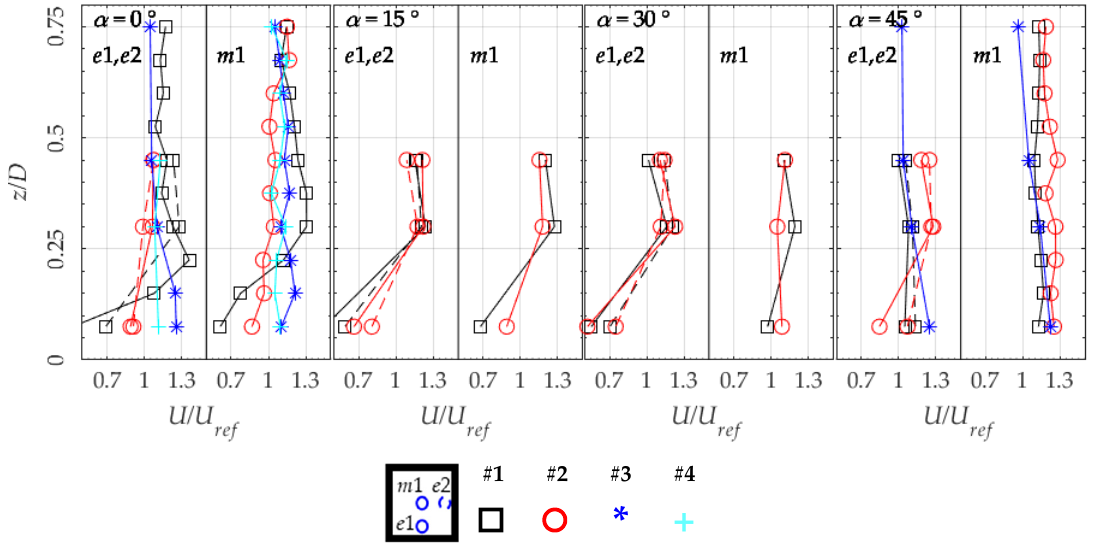
Figure 8. Mean wind speed at positions e 1, m 1 and e 2 (dashed) as indicated in the legend, for configurations #1, #2, #3, and #4, for the four wind directions. The plot on the left shows e 1 and e 2, while on the right m 1.